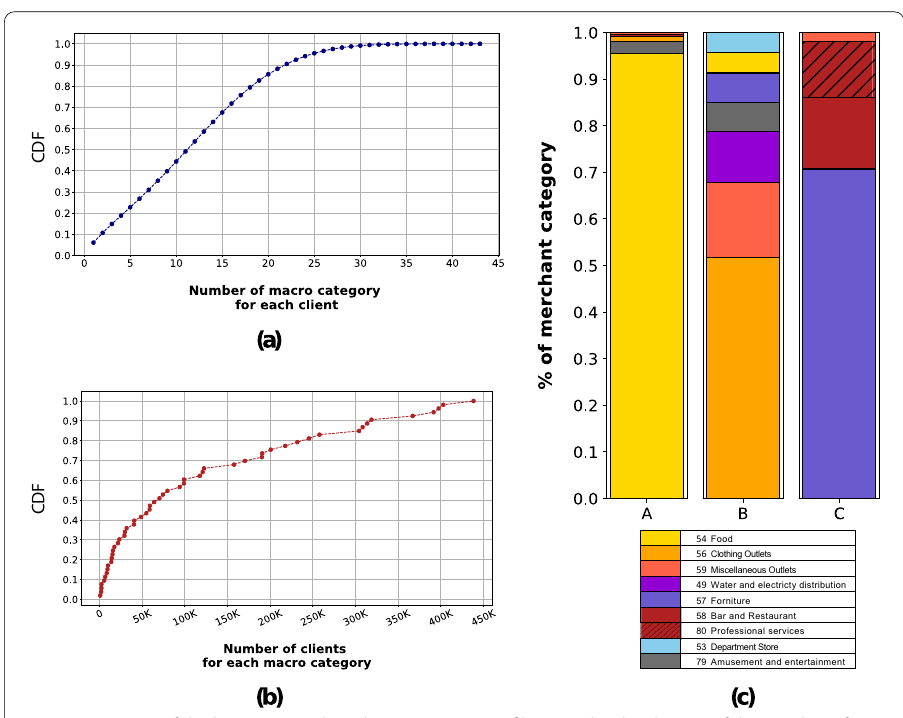
Fig. 3 Properties of the bipartite graph and consumption profiles. In a the distribution of the number of different merchant categories per customer. In b the distribution of the number of customers associated to a merchant category. In c three examples of consumption profiles displayed as stacked barplots. In each stacked barplot, the height of the bar is proportional to the percentage of money spent for goods/services in the merchant categories indicated in the